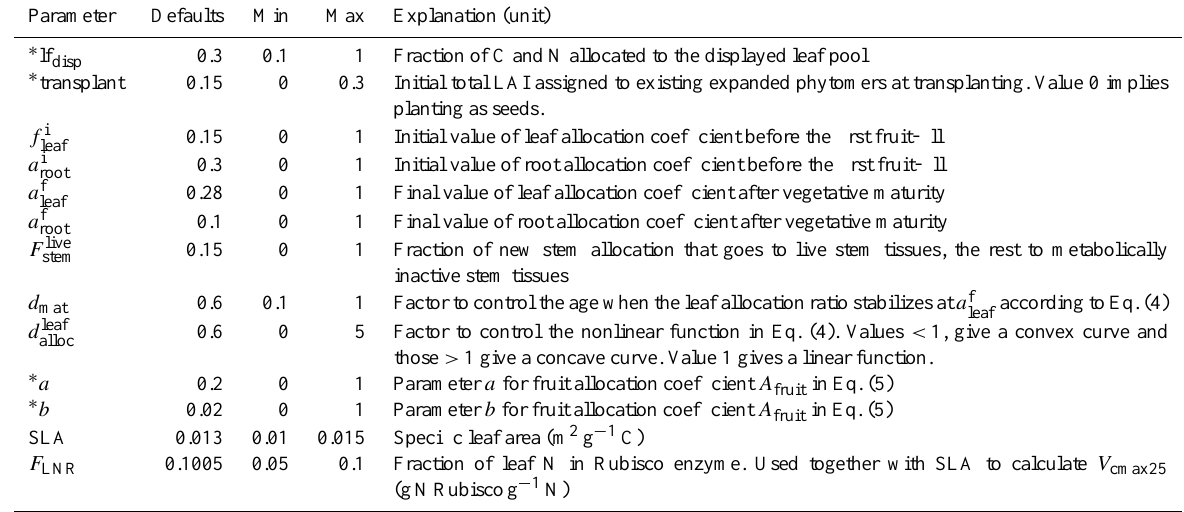
Table A2. Summary of parameters involved in C and N allocation. The default values were determined by calibration and with reference to field measurements (Kotowska et al.,